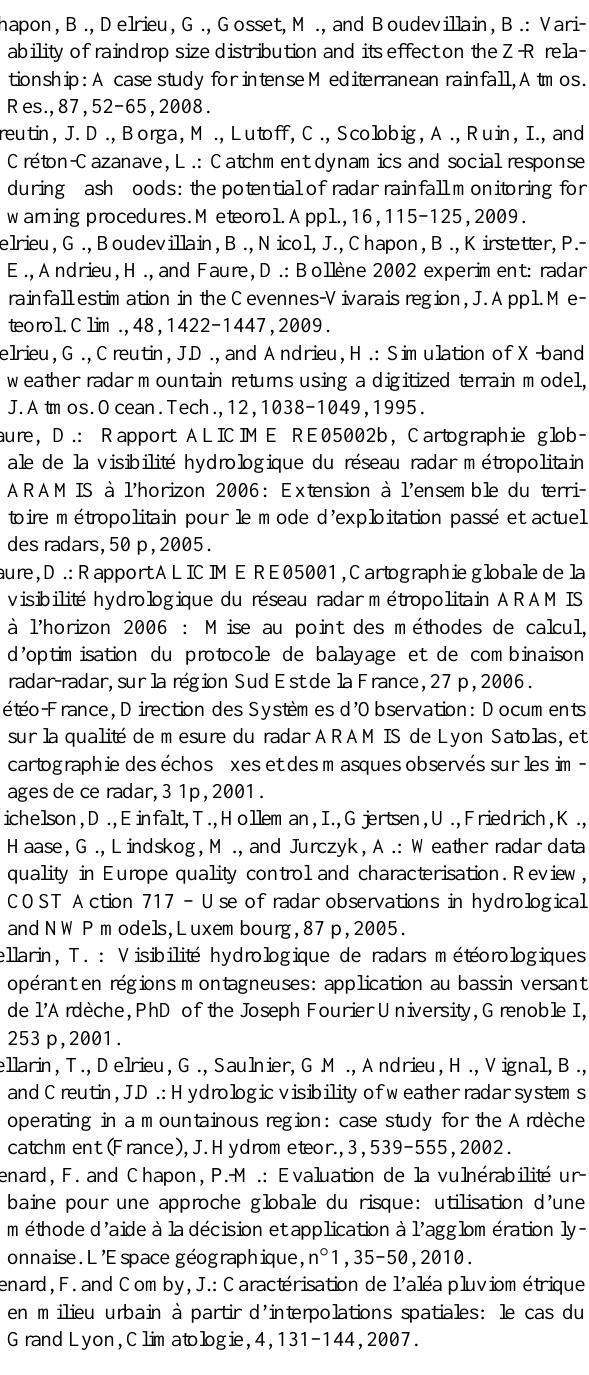
Fig. 4. Same as Fig. 3 but with a zoom on the Greater